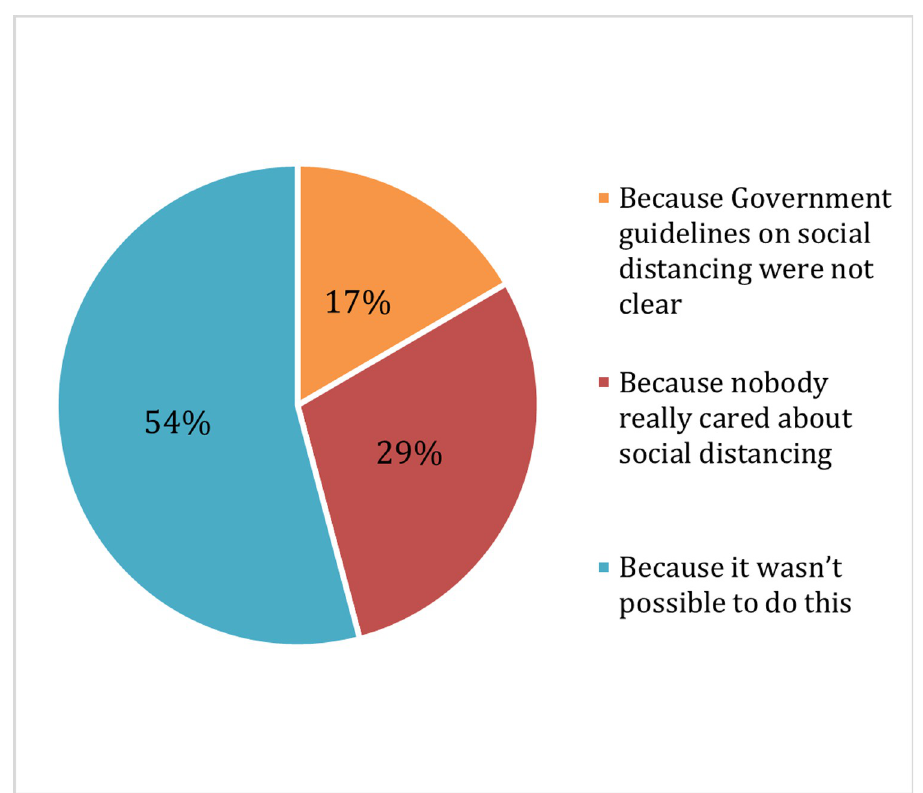
Fig 2. Reasons for not complying with social distancing